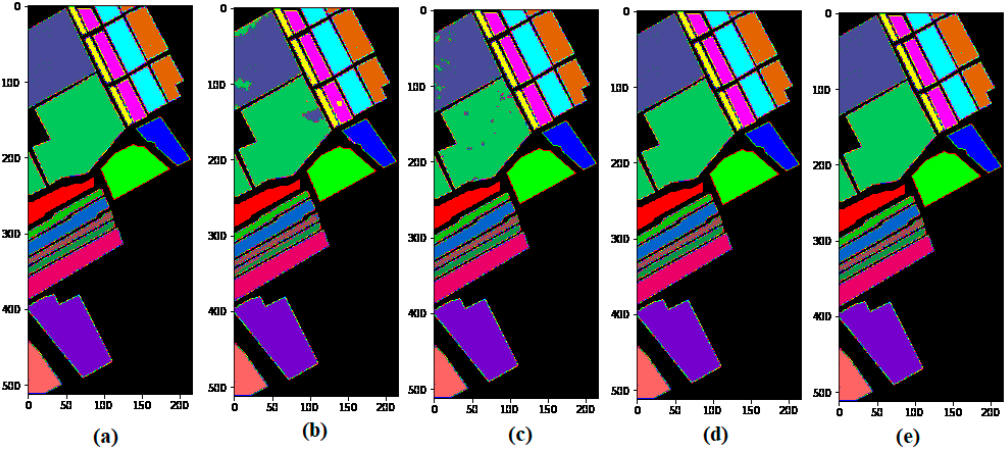
Figure 11. Classification maps of the Salinas (SA) dataset: ( a ) Ground truth; ( b ) M3D-CNN; ( c ) SSRN; ( d ) HybridSN; ( e ) GGBN.